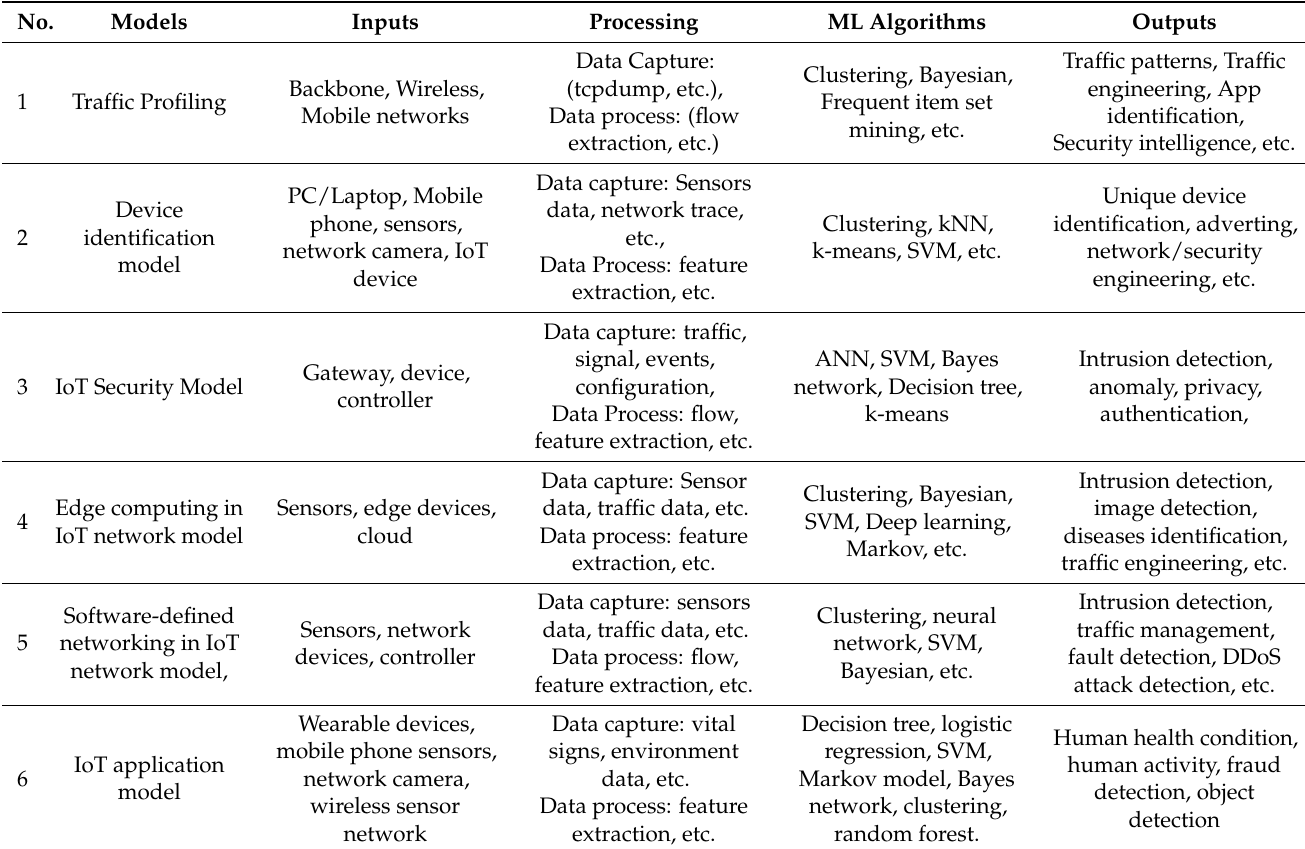
Table 4. Application of Machine Learning Algorithms for